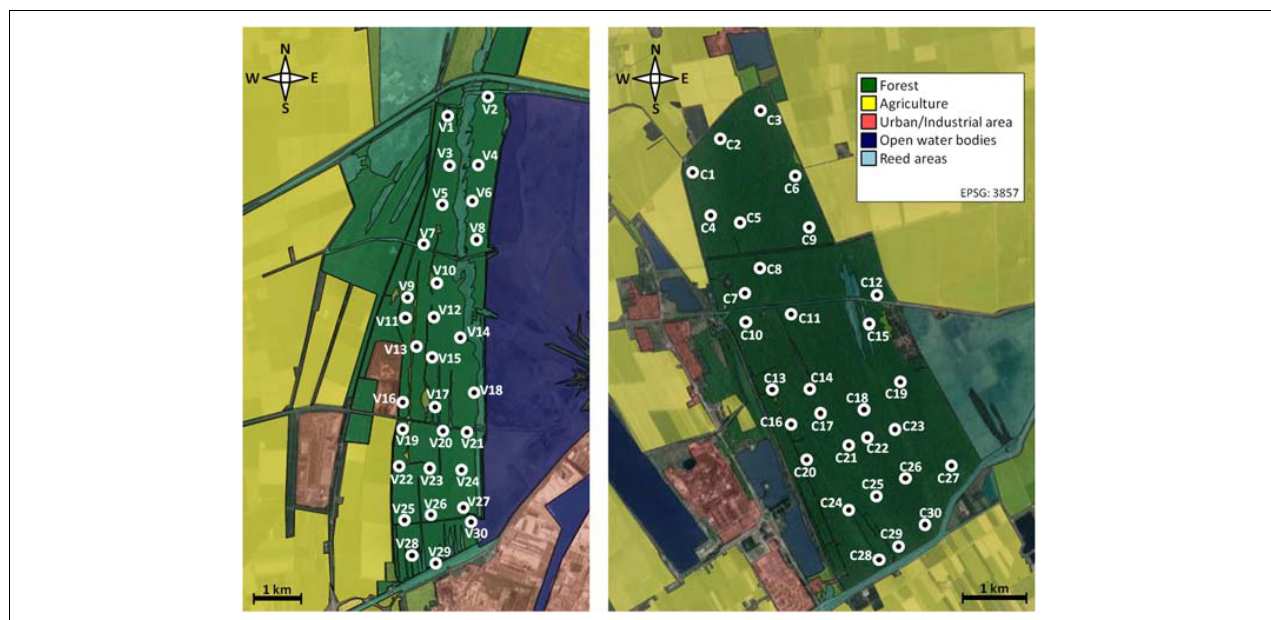
FIGURE 1 | Map showing the 60 study sites (white circles) within the two investigation areas in NE Italy (left: Pineta san Vitale, right: Pineta di Classe). The map is based on Google Maps TM satellite images and modified via QGIS. The coordinates of the two reserves are: 44 ◦ 27 (cid:48) 48.09 (cid:48)(cid:48) to 44 ◦ 31 (cid:48) 39.15 (cid:48)(cid:48) N; 12 ◦ 13 (cid:48) 01.08 (cid:48)(cid:48) to 12 ◦ 14 (cid:48) 16.97 (cid:48)(cid:48) E (Pineta san Vitale), 44 ◦ 19 (cid:48) 35.00 (cid:48)(cid:48) to 44 ◦ 22 (cid:48) 36.35 (cid:48)(cid:48) N; 12 ◦ 15 (cid:48) 35.51 (cid:48)(cid:48) to 12 ◦ 18 (cid:48) 04.46 (cid:48)(cid:48) E (Pineta di